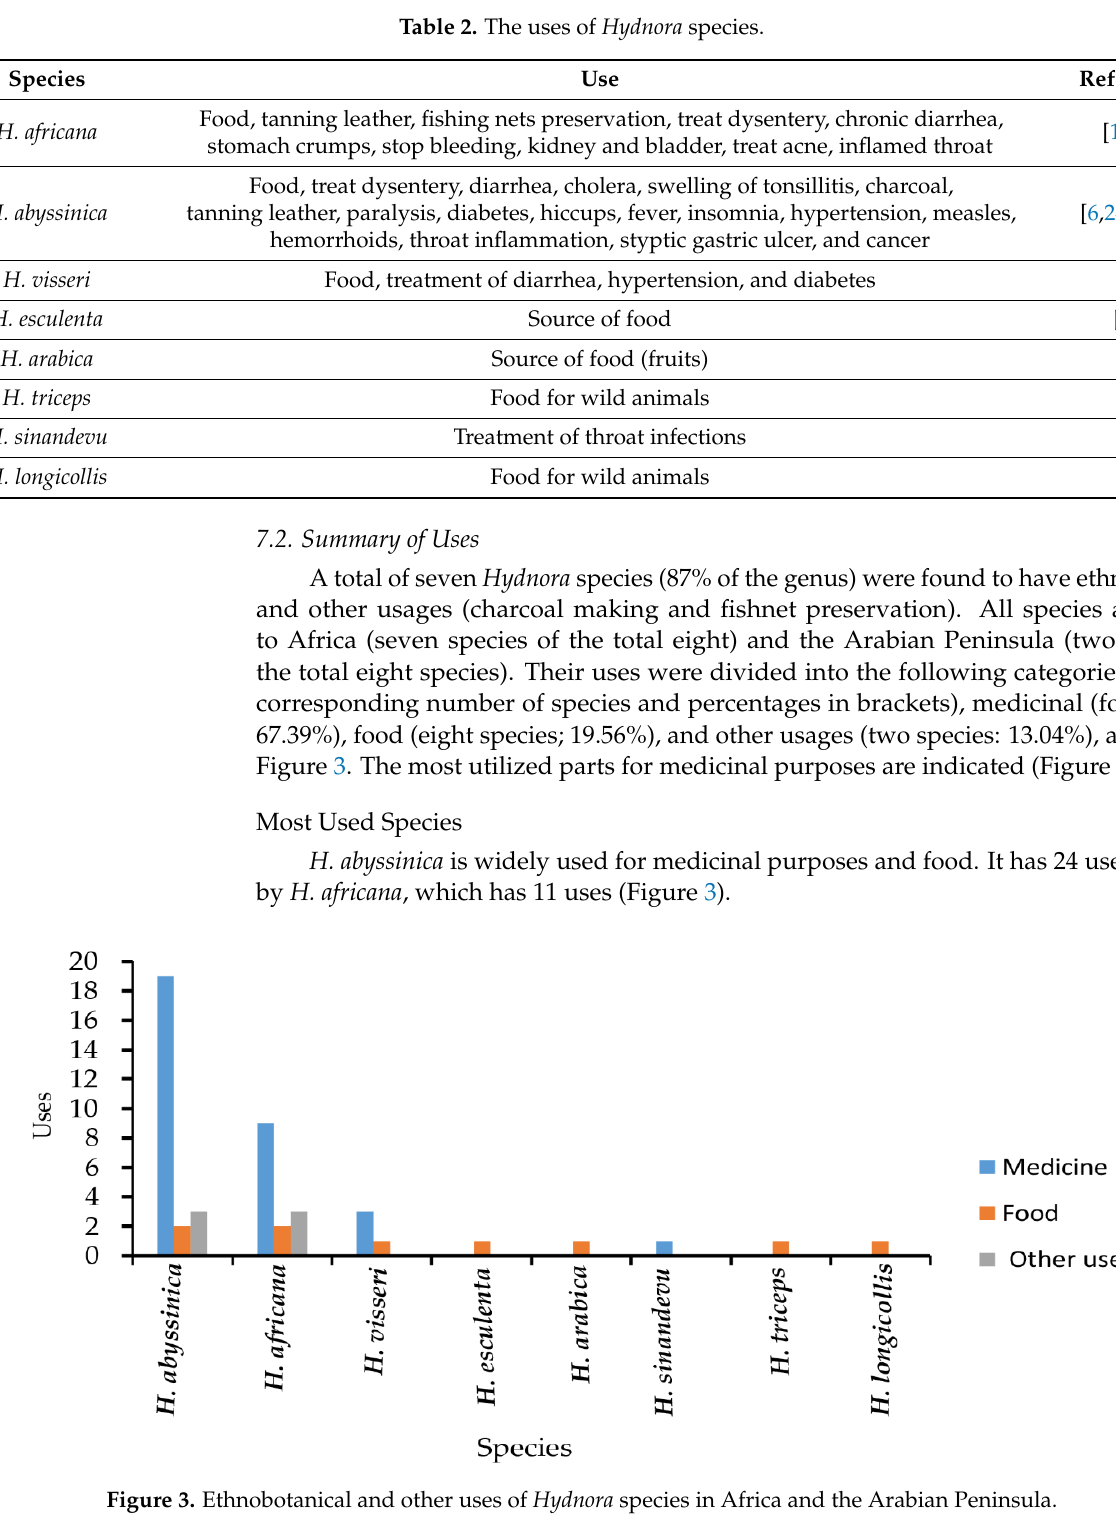
Table 2. The uses of Hydnora species.